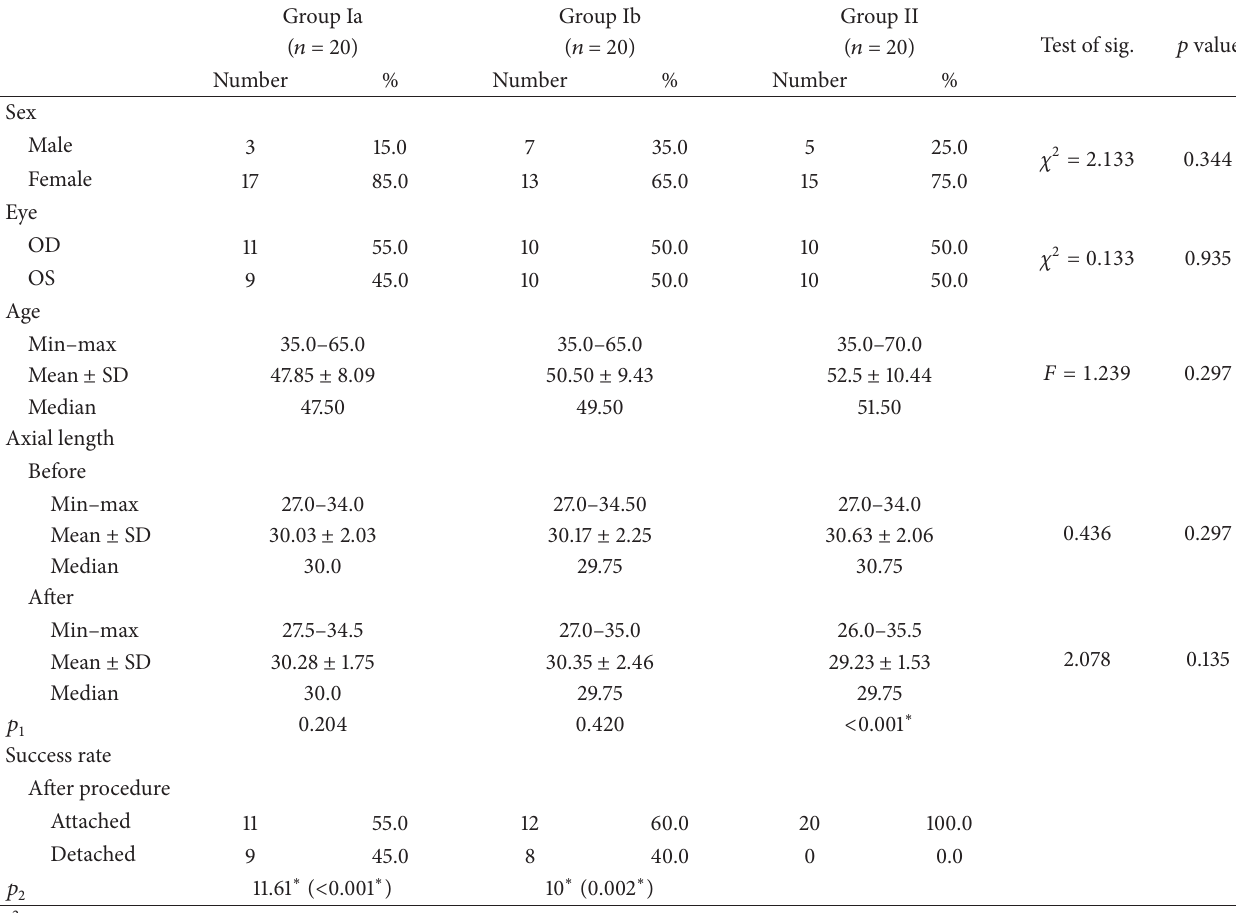
Table 1: Demographic data of the studied